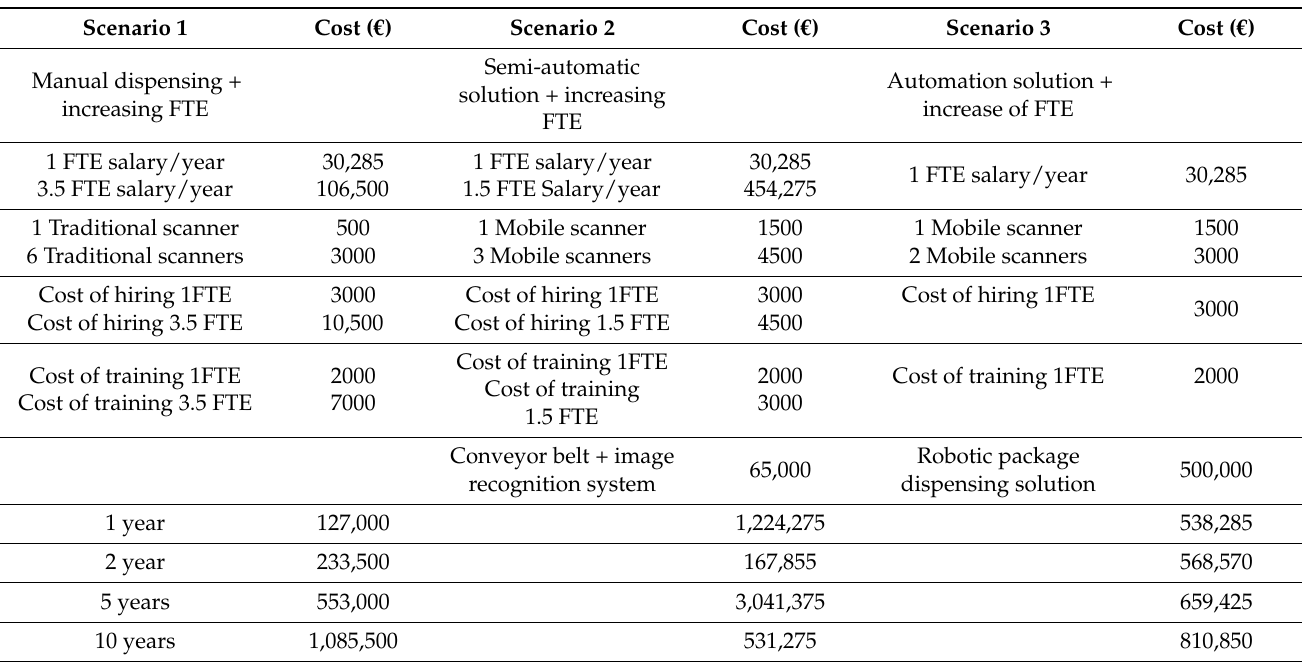
Table 2. Financial analysis exposing different scenarios of the implementation of the FMD in the case